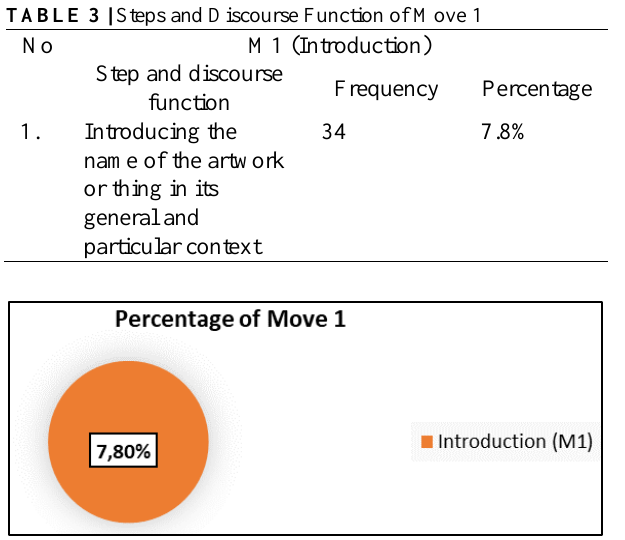
FIGURE 2 | Percentage of Move 1